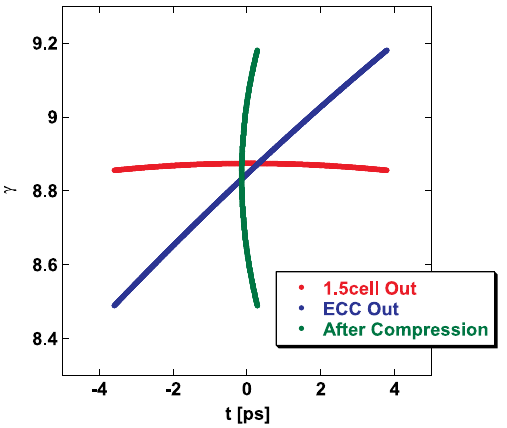
FIG. 4 (color online). Phase space distribution at the end of part A (red), end of part B (blue), and at 2.33 m away from the cathode.